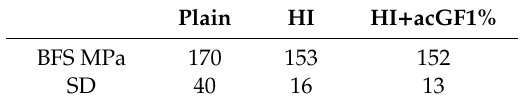
Figure 16. BFS of high-impact resin with and without added glass flakes, compared to plain denture resin.